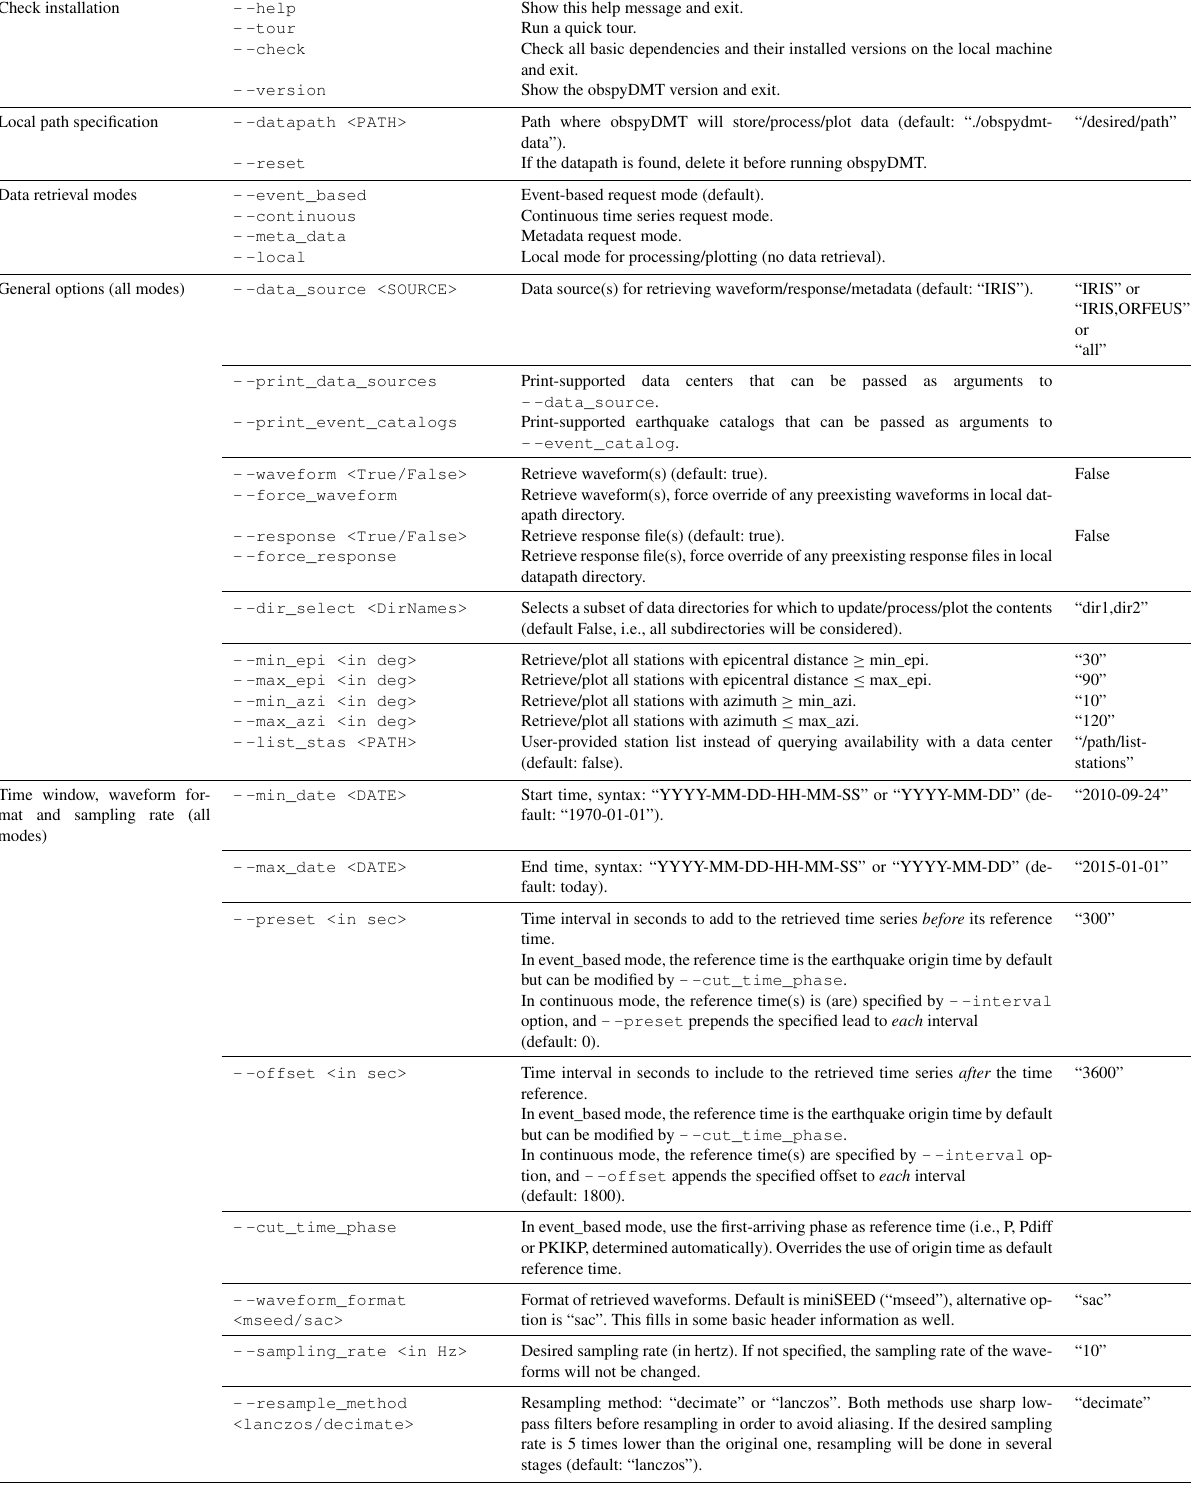
Table 2. Complete list of option flags to customize the default behavior of the obspyDMT command. Group Options Description